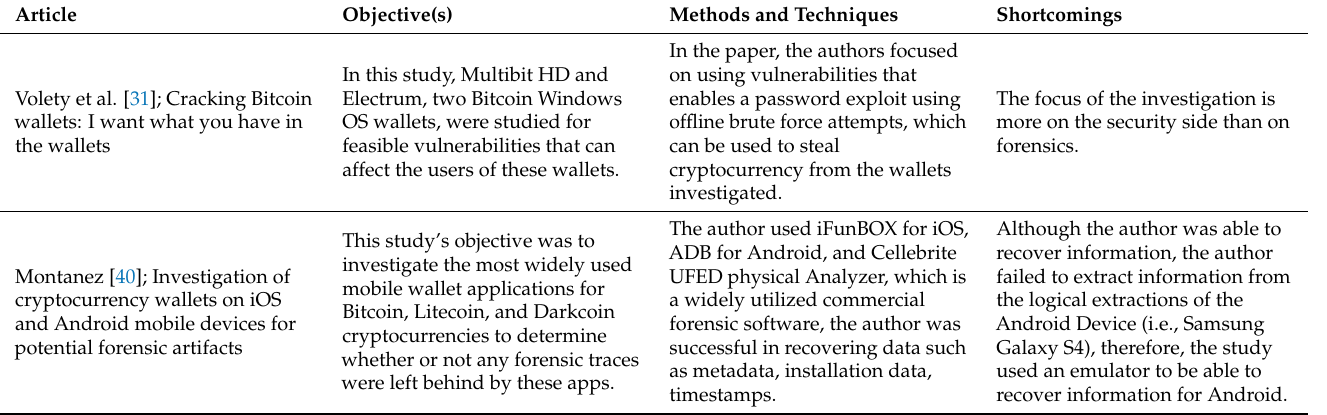
Table 2. A summary of some shortcomings in related